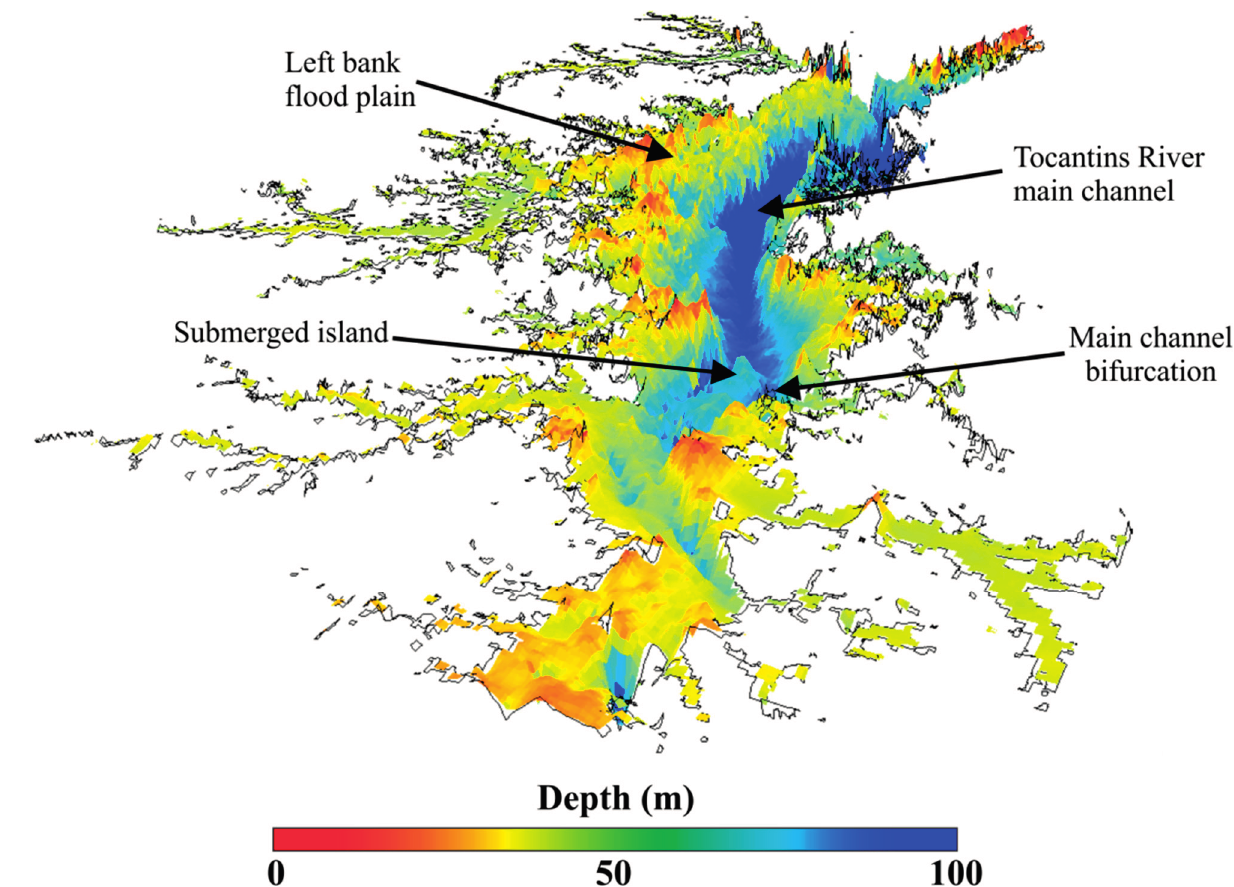
Figure 8. Three-dimensional view of reservoir